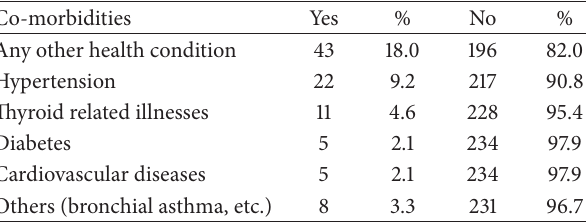
Table 6: Patient reported co-morbidities ( 𝑁 = 239 ).